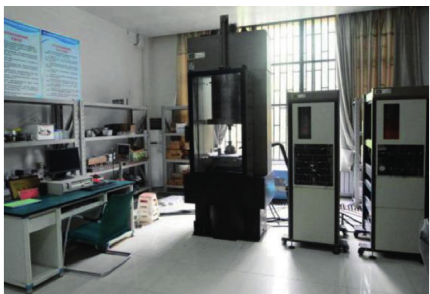
Figure 4: MTS rock servo test